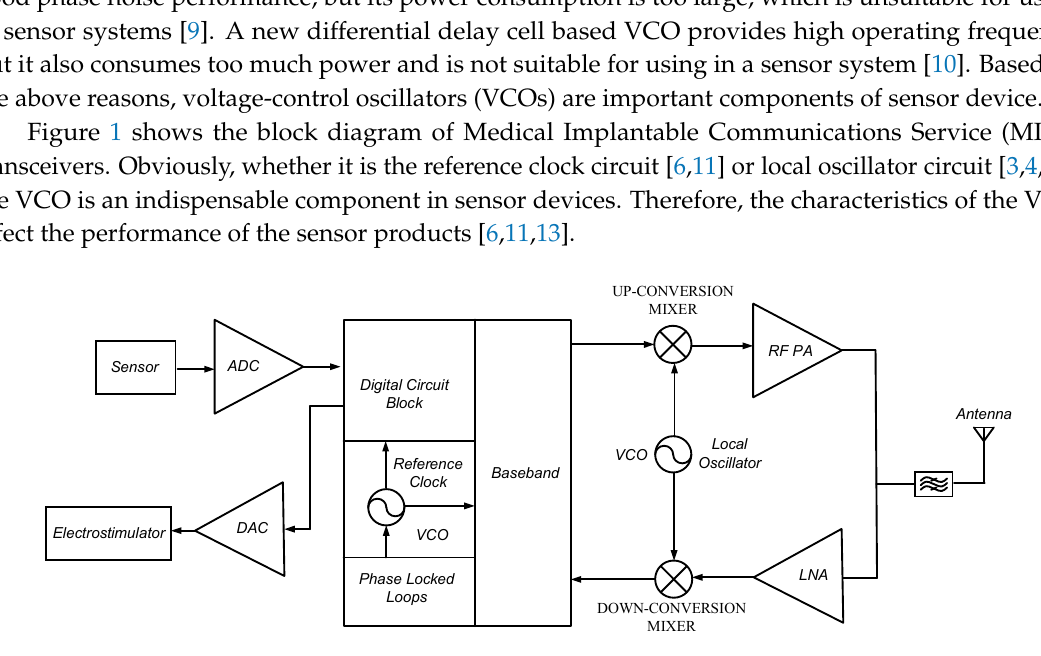
Figure 1. The block diagram of Medical Implantable Communications Service (MICS) transceivers.